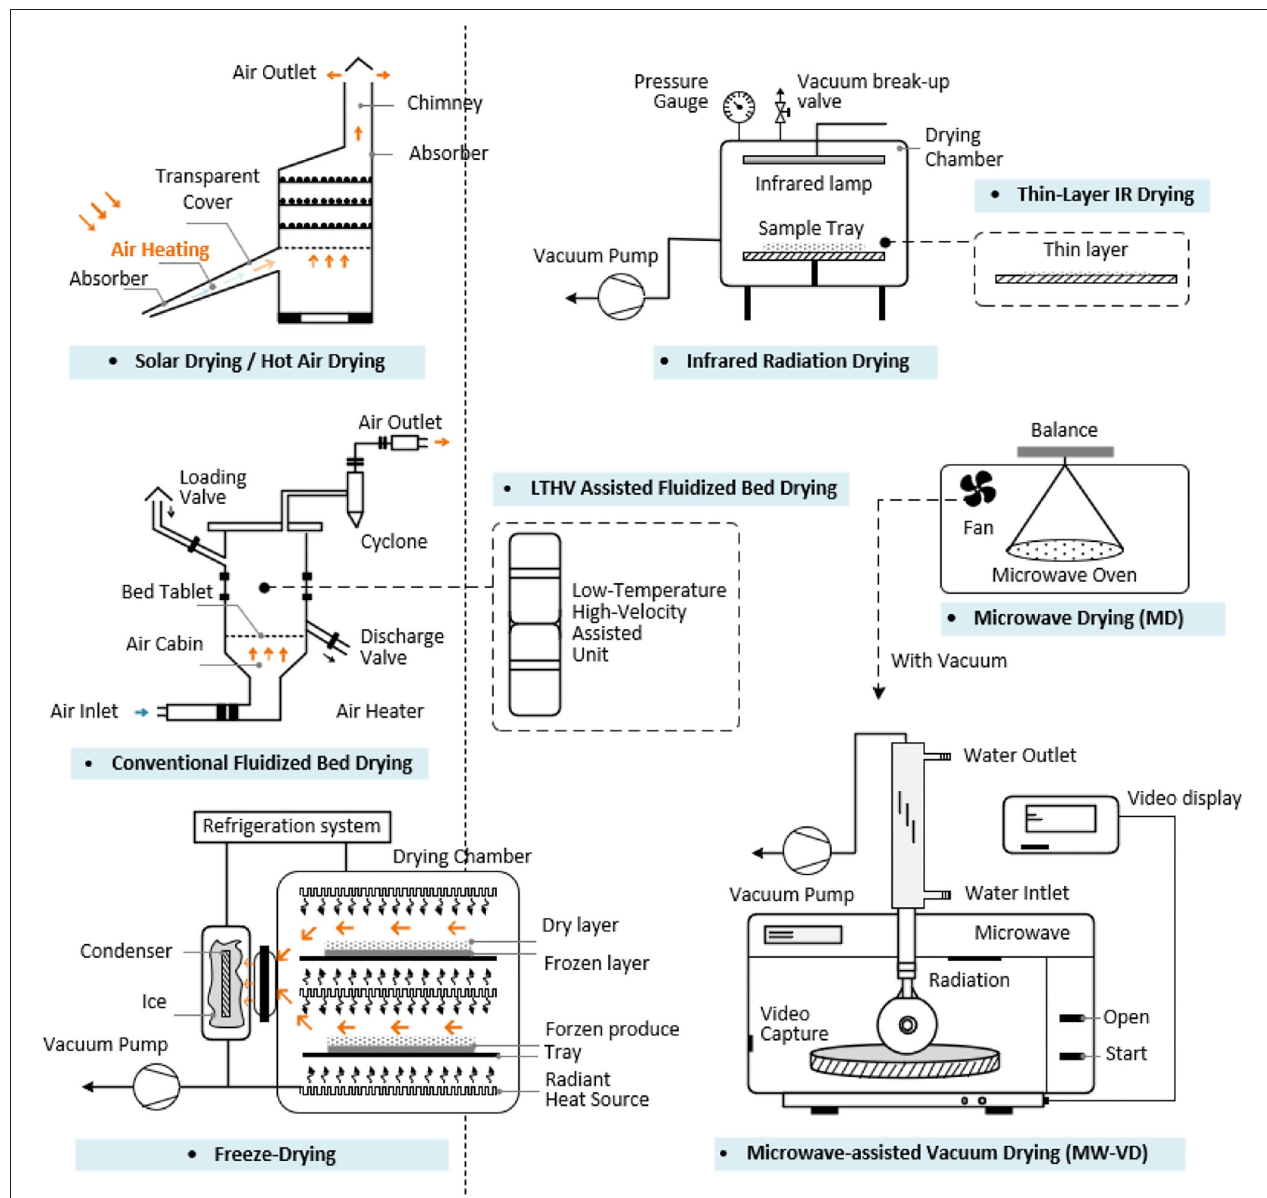
FIGURE 4 | The effects of each drying